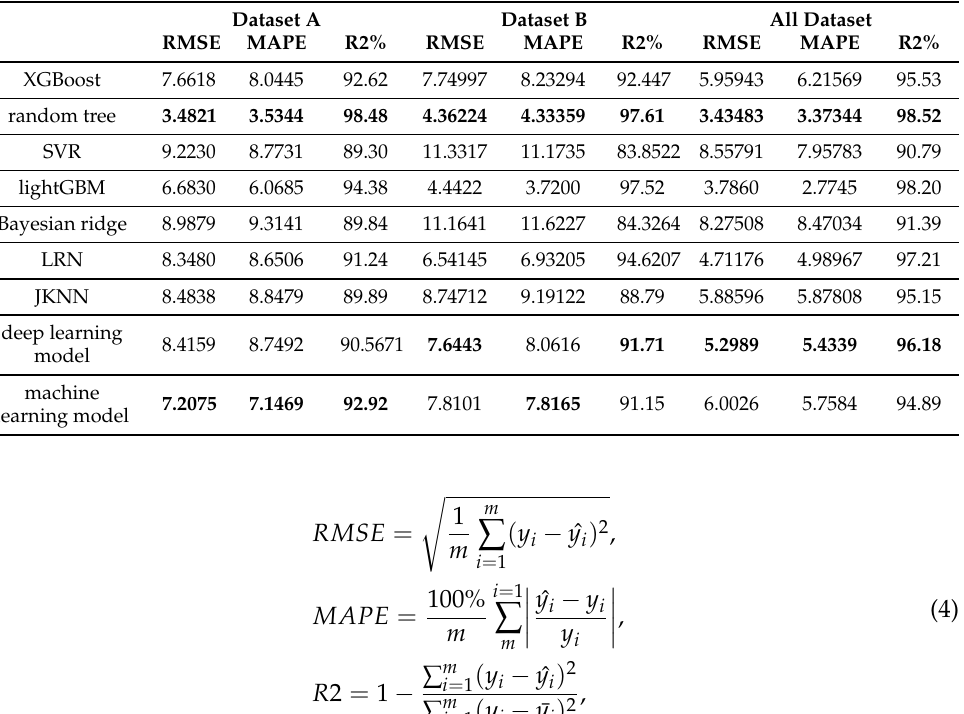
Table 3. Comparative result in dataset A, dataset B, and all